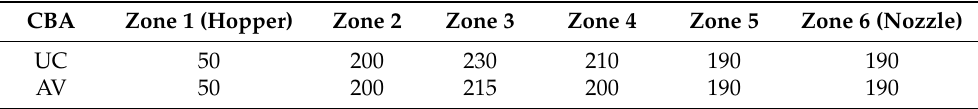
Table 4. Barrel temperature profiles used for each CBA to ensure activation. All temperatures are in